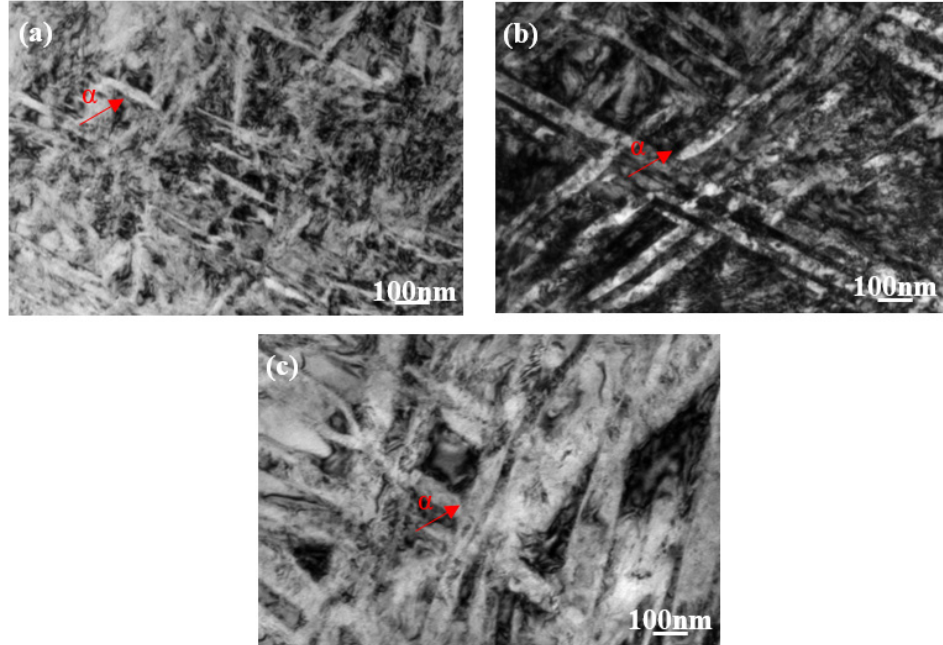
Figure 4. TEM images of the alloys with different aging treatment after fatigue tests under 0.4% total strain range. ( a ) 4 h, ( b ) 12 h and ( c ) 24 h.